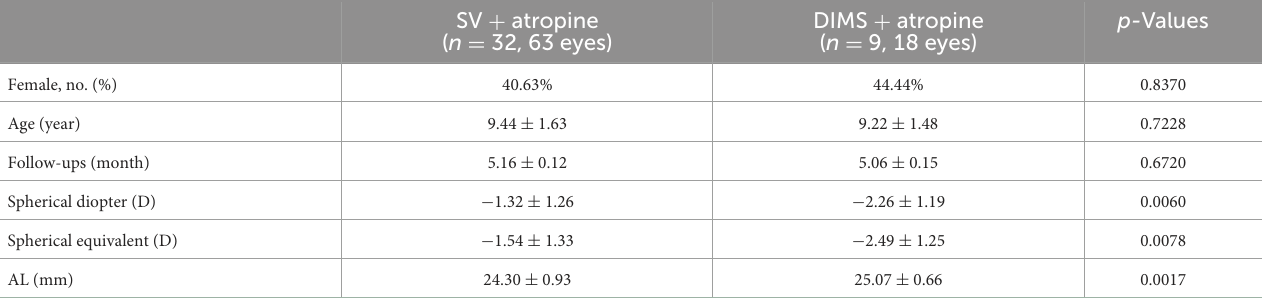
SV + atropine ( n = 32, 63 eyes)